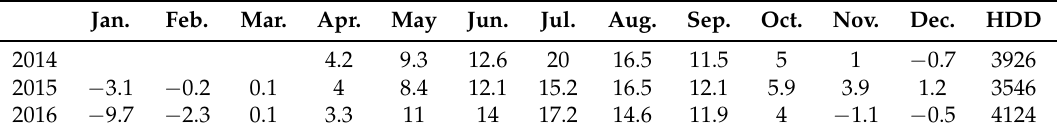
Table 1. The monthly mean air temperatures [ ◦ C] measured during April 2014–December 2015 at the weather station of the Finnish Meteorological Institute [17] and the heating degree days (HDD) in Vaasa